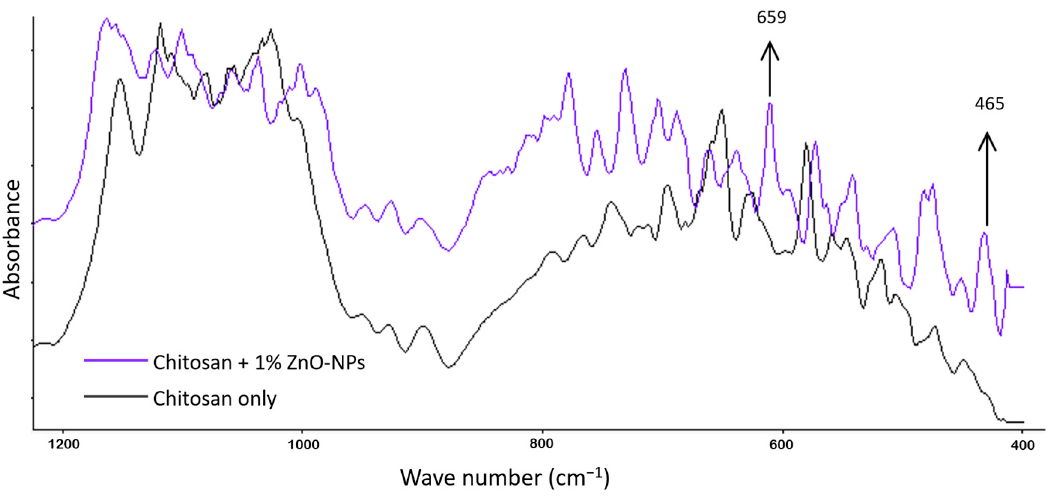
Figure 6. FTIR spectra of chitosan and chitosan + 1% ZnO-NP.